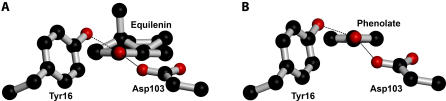
Structure of Equilenin (1OGX) and Phenolate Bound to pKSID40N, Showing the Hydrogen Bonds from Tyr16 and Asp103 That Come from Above and Below the Plane of the Steroid
(A) For equilenin (PDB Code 1OGX [72]), average angles out of the plane of the steroid ring are 28° and 46°.
(B) For phenolate, the average angles are 15° and 47°.